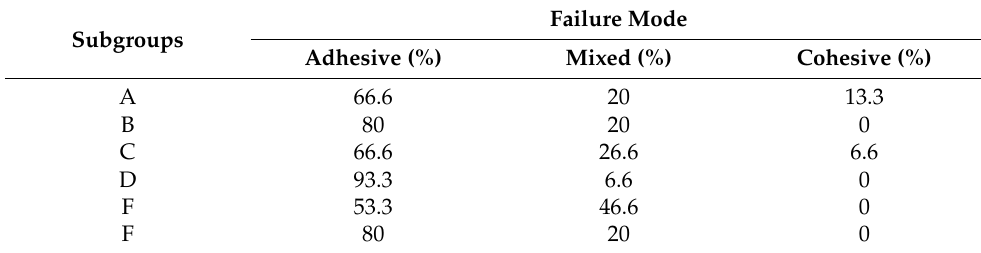
Table 4. Frequency distribution of type of fracture for six